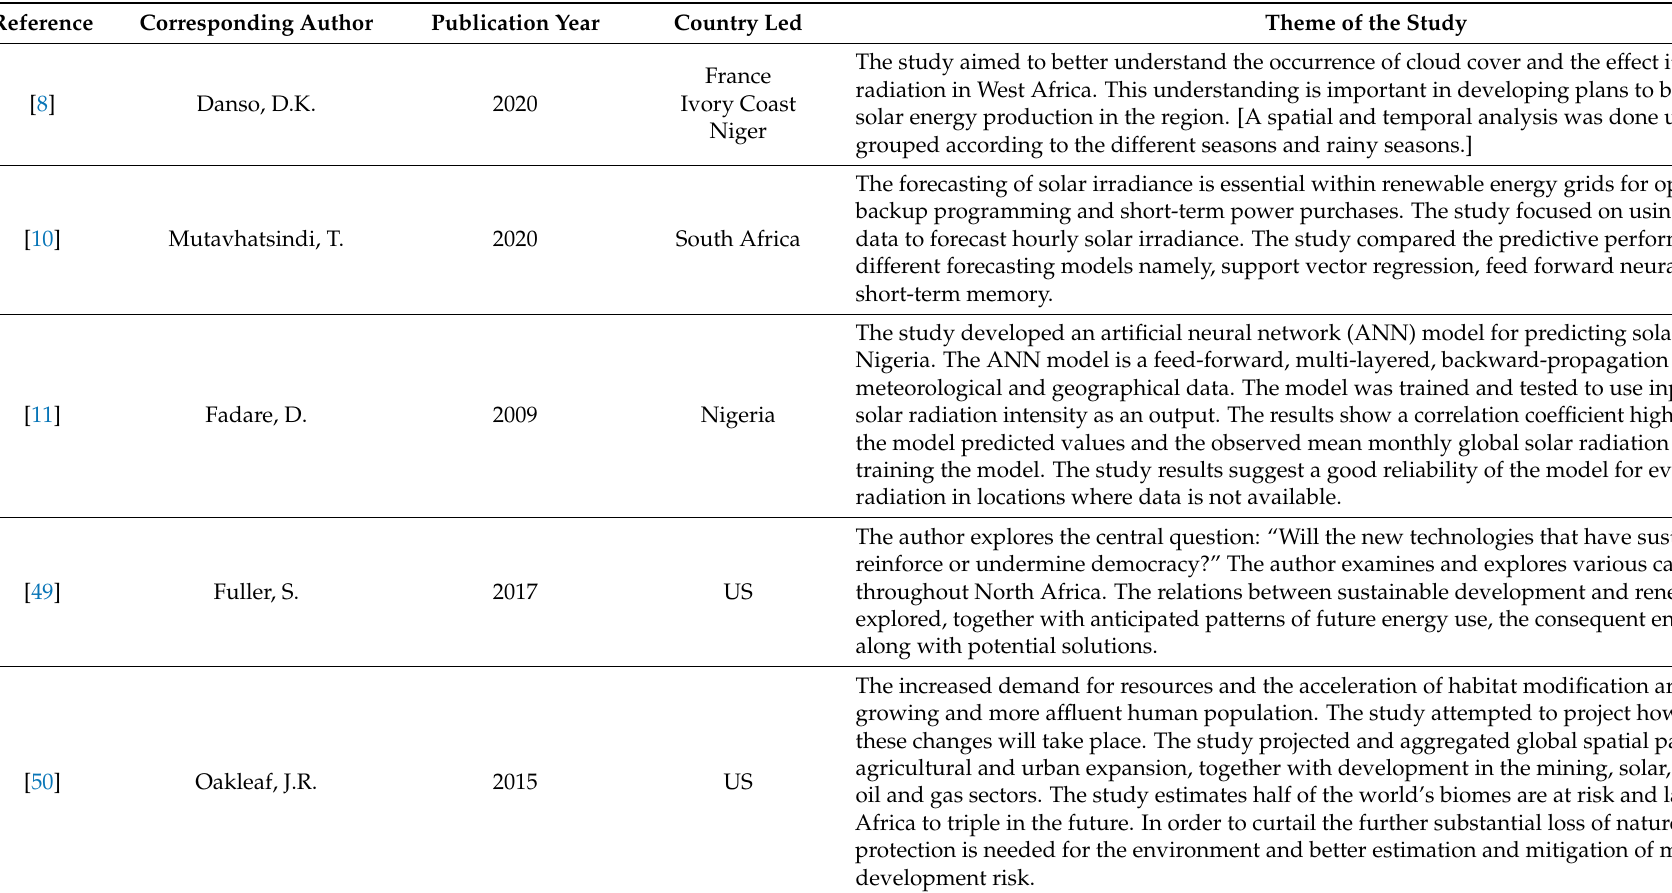
Table 1. Summary of selected scientific publications on solar energy forecasting studies conducted in